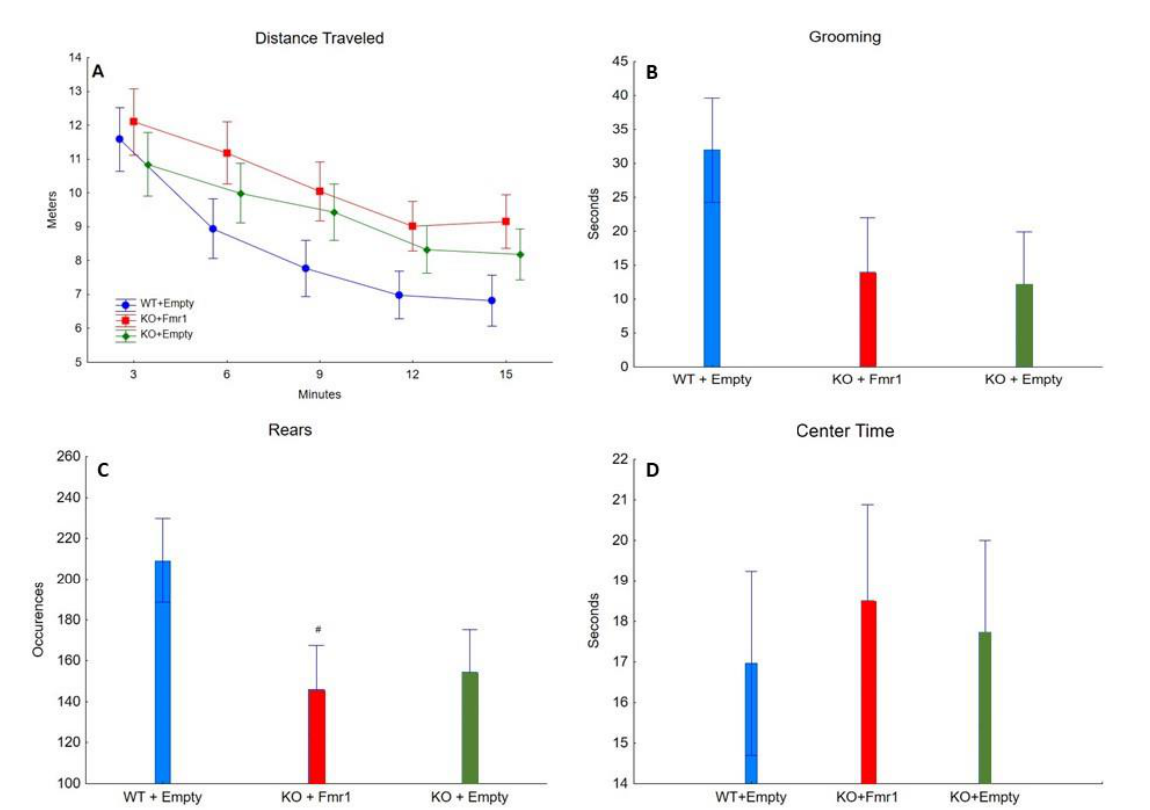
Figure 4. Open Field. The effect of the three treatments on open field. ( A ) Distance traveled (in meters) by the mice from the three groups during the 15 min of open field. ( B ) The time (seconds) the mice of the three groups spent grooming. ( C ) The number of times the mice of the three groups engaged in rearing. # = p < 0.05. ( D ) The time (seconds) the mice of the three groups spent in the center of the apparatus throughout the test.